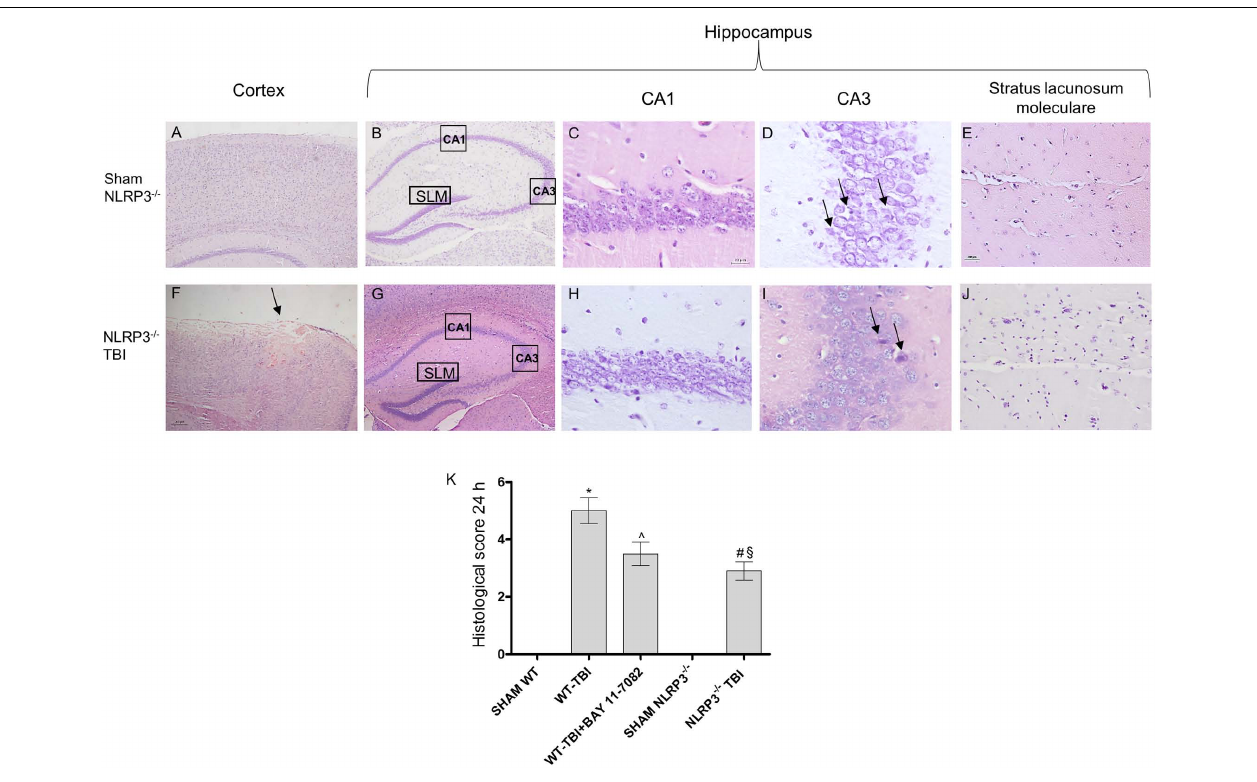
FIGURE 4 | Representative H&E staining of brain tissue from NLRP3 − / − mice 24 h following TBI. (A) Cortex of Sham NLRP3 − / − animal. Original magnification X5. (B) Hippocampus of Sham NLRP3 − / − animal. The rectangle indicates the Ca1, Ca3, and stratus lacunosum moleculare areas used for enlargement. Original magnification X5. (C) Ca1 area of Sham NLRP3 − / − animal. Original magnification X40. (D) Ca3 area of Sham NLRP3 − / − animal. Original magnification X40. (E) Stratus lacunosum moleculare of Sham NLRP3 − / − animal. Original magnification X20. (F) Cortex of NLRP3 − / − -TBI animal, the arrow indicates the impact point, hemorrhage and edema are markedly visible. Original magnification X5. (G) Hippocampus of NLRP3 − / − -TBI animal. The rectangle indicates the Ca1, Ca3, and stratus lacunosum moleculare areas used for enlargement. Original magnification X5. (H) Ca1 area of NLRP3 − / − -TBI animal, showing a preserved architecture, absence of hemorrhage and edema, with few shrank neurons. Original magnification X40. (I) Ca3 area of NLRP3 − / − -TBI animal, showing neuronal loss and presence of eosinophil neurons (arrows). Original magnification X40. (J) Stratus lacunosum moleculare of NLRP3 − / − -TBI animal, showing an almost normal architecture. Original magnification X20. (K) The graph represents the cumulative histological score evaluated at 24 hours from each group of animals. ∗ p < 0.05 vs Sham WT; ˆ p < 0.05 vs WT-TBI; # p < 0.05 vs Sham NLRP3 − / − ; § p < 0.05 vs WT-TBI. Each bar represents the mean and SD of seven